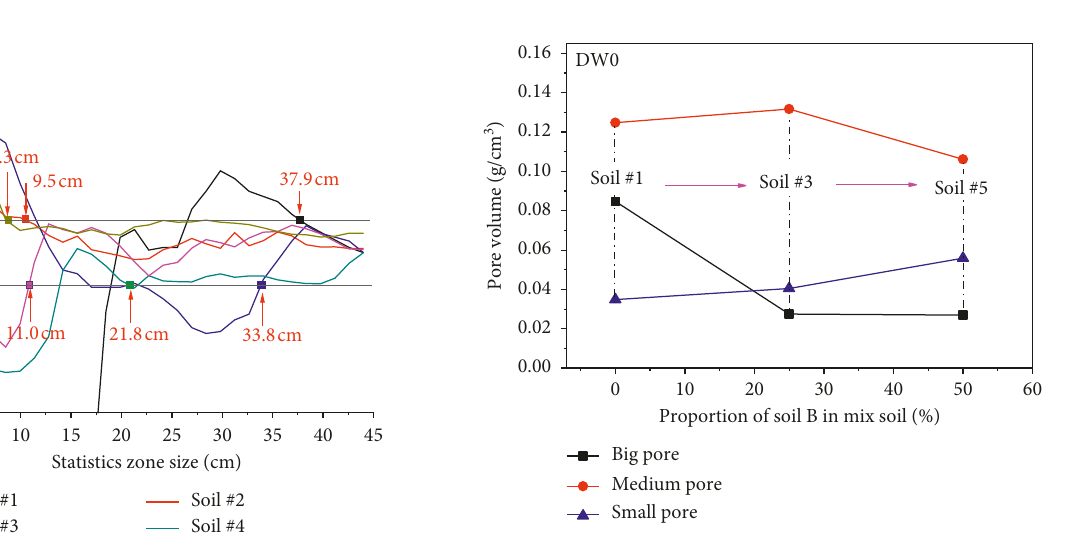
Figure 8: PSD in the CCLs before DW0 and DW3.